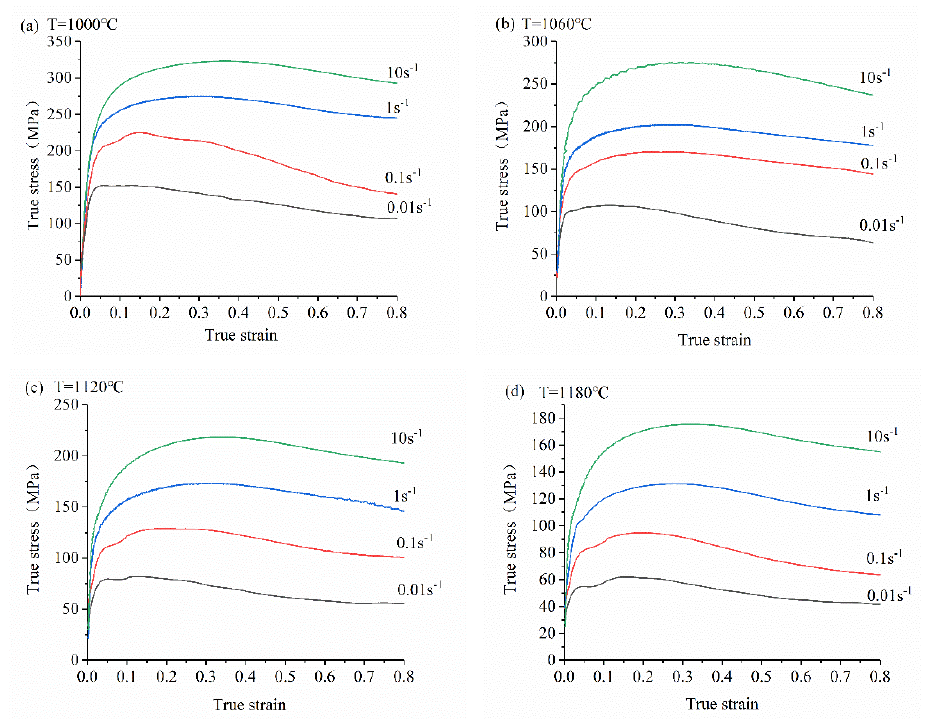
ff erent deformation